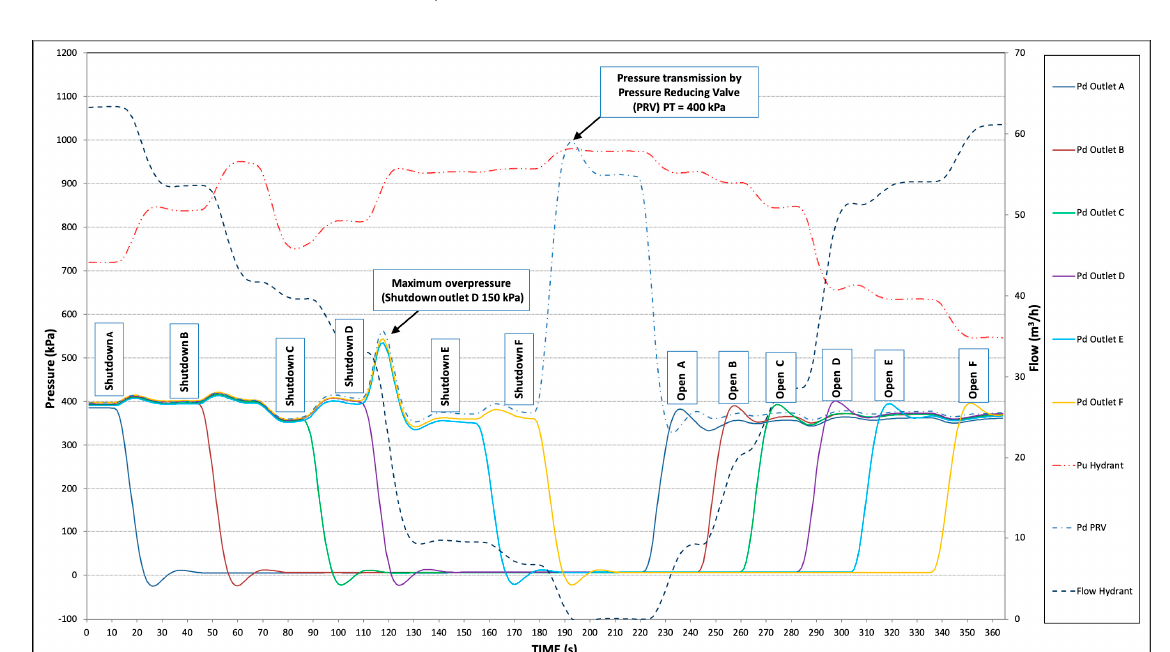
Figure 11. Transient test laboratory.